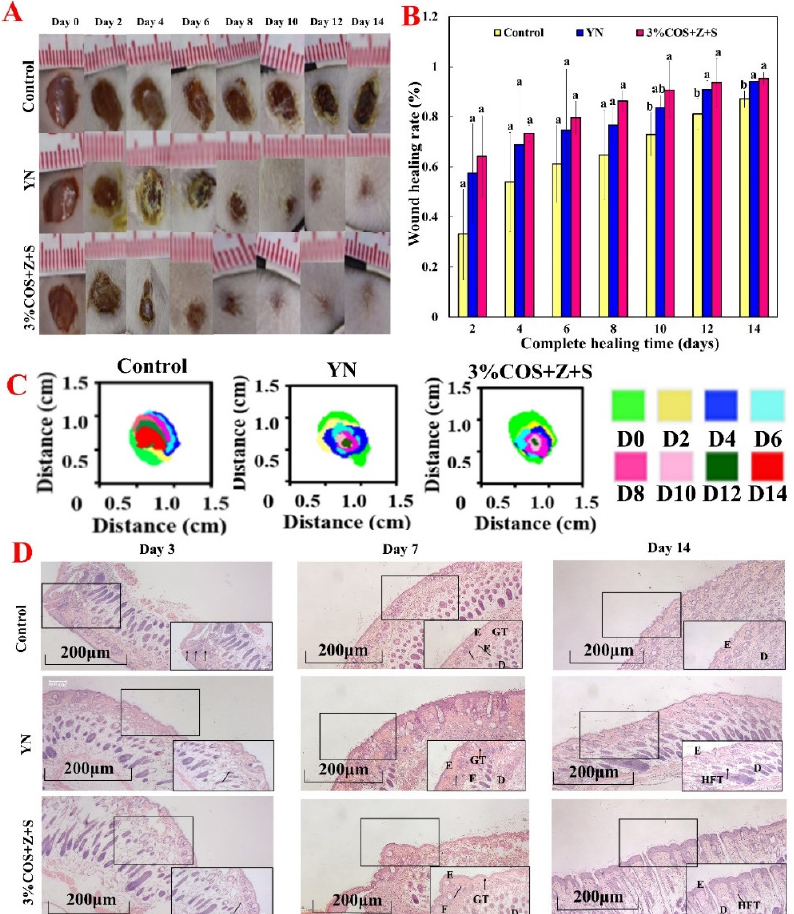
Figure 5. Evaluation of wound healing ability of nIon 2+ − COS/SA gel films. NIon 2+ − COS/SA gel film is shown in A − C for the evaluation of wound defects in mice. ( A ) Representative photographs of wounds in mice on days 0, 2, 4, 6, 8, 10, 12 and 14. ( B ) Wound healing rate of each group (calculated every two days). Values are expressed as mean ± standard deviation, n = 3. Note: Same superscript letters indicate non-significant differences ( p > 0.05), different superscript letters indicate significant differences ( p < 0.05). ( C ) Simulated changes in wound size and morphology at 8 time points. ( D ) Representative images of H&E staining (5 × ). Note: Thick black arrows indicate inflammatory cell infiltration. Letters D, E, F, GT and HFT represent dermis, epidermis, fibroblasts, granulation tissue and hair follicle tissue, respectively.